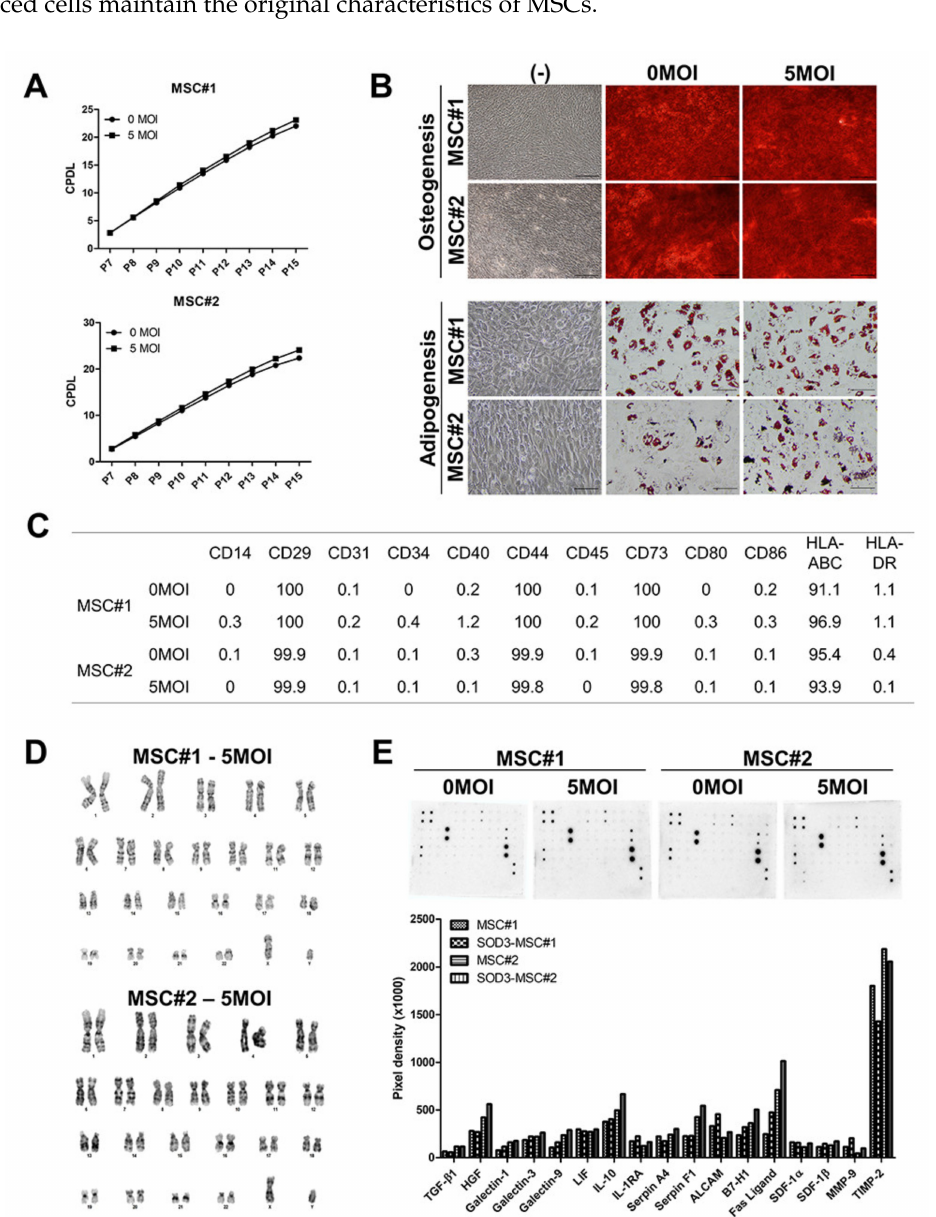
Figure 2. MSC characterization after SOD3 transduction. ( A ) Cumulative population doubling level (CPDL) of MSCs through continuous passaging from P7 to P15. ( B ) MSCs were induced to di ff erentiate into osteoblasts and adipocytes for two and three weeks and were stained by Alizarin Red S and Oil Red O, respectively. Scale bar = 100 µ m. ( C ) Analysis of surface marker expression in MSCs by flow cytometry. ( D ) Karyotyping of SOD3-transduced MSCs. ( E ) Cytokine array of MSC-derived conditioned media. Quantification of the pixel density for each identified cytokine in MSCs. Data are normalized after background